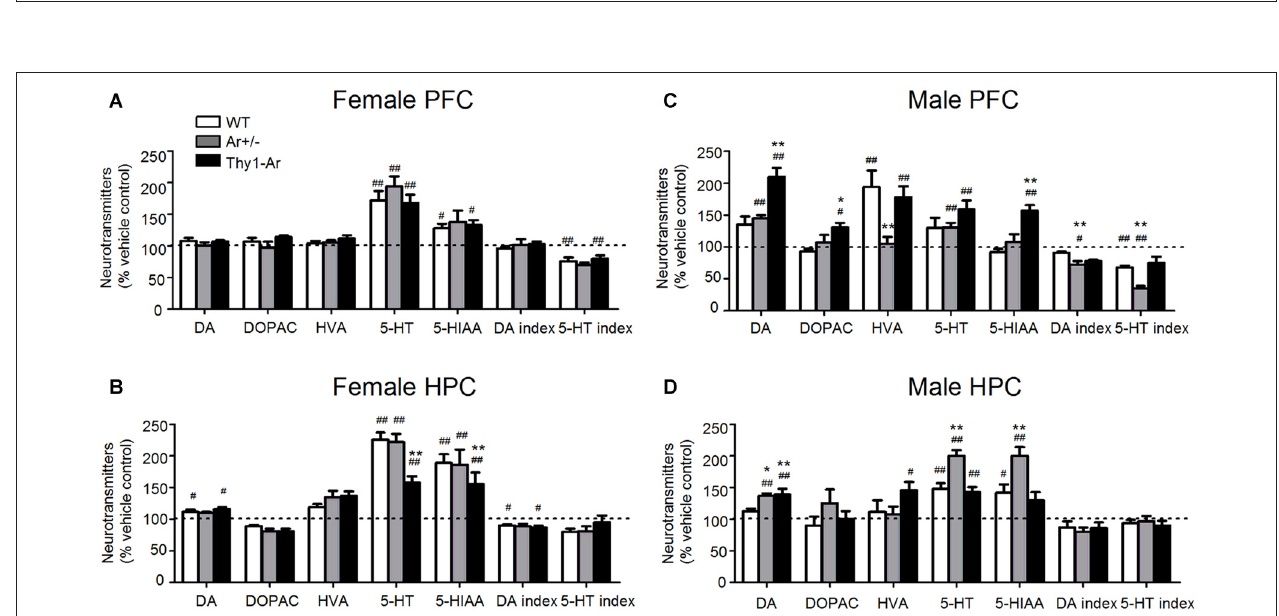
FIGURE 3 | Sex differences in the effect of endogenous estrogen on dopamine (DA) and serotonin (5-HT) turnover rates in the prefrontal cortex (PFC) and hippocampus (HPC). The effect of endogenous estrogen on DA and 5-HT index of three genotype in female PFC (A) , female HPC (B) , male PFC (C) and male HPC (D) . ∗ Indicate P < 0.05 and ∗∗ P < 0.01 compared to WT mice. n = 6–7 mice/group.